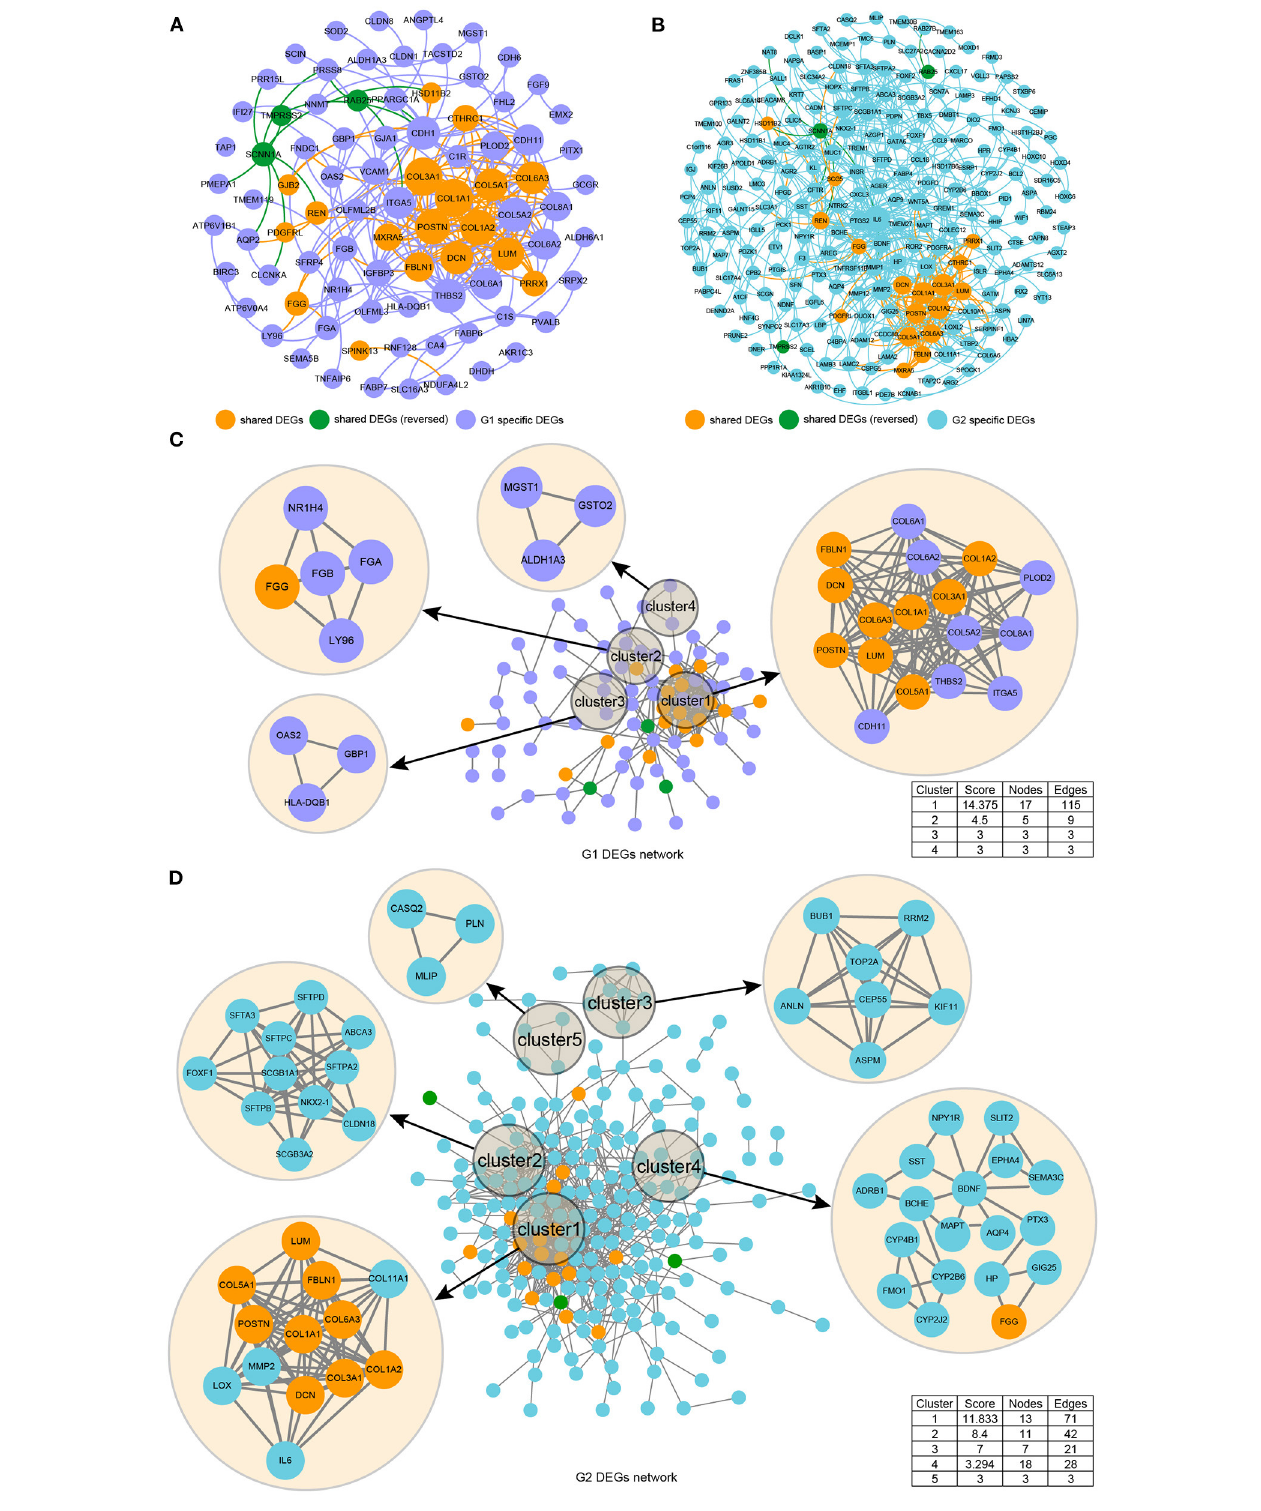
FIGURE 3 | Illustration of the protein networks of DEGs from the GSE105261 (G1) and GSE85258 (G2) datasets. The spatial distribution characteristics of the PPI network model of G1 (A) and G2 (B) based on a macro perspective were constructed by the “Fruchterman–Reingold” layout in the Gephi software. The spatial distribution characteristics of the PPI network model of G1 (C) and G2 (D) based on independent perspectives were constructed by the MCODE plugin of Cytoscape software.